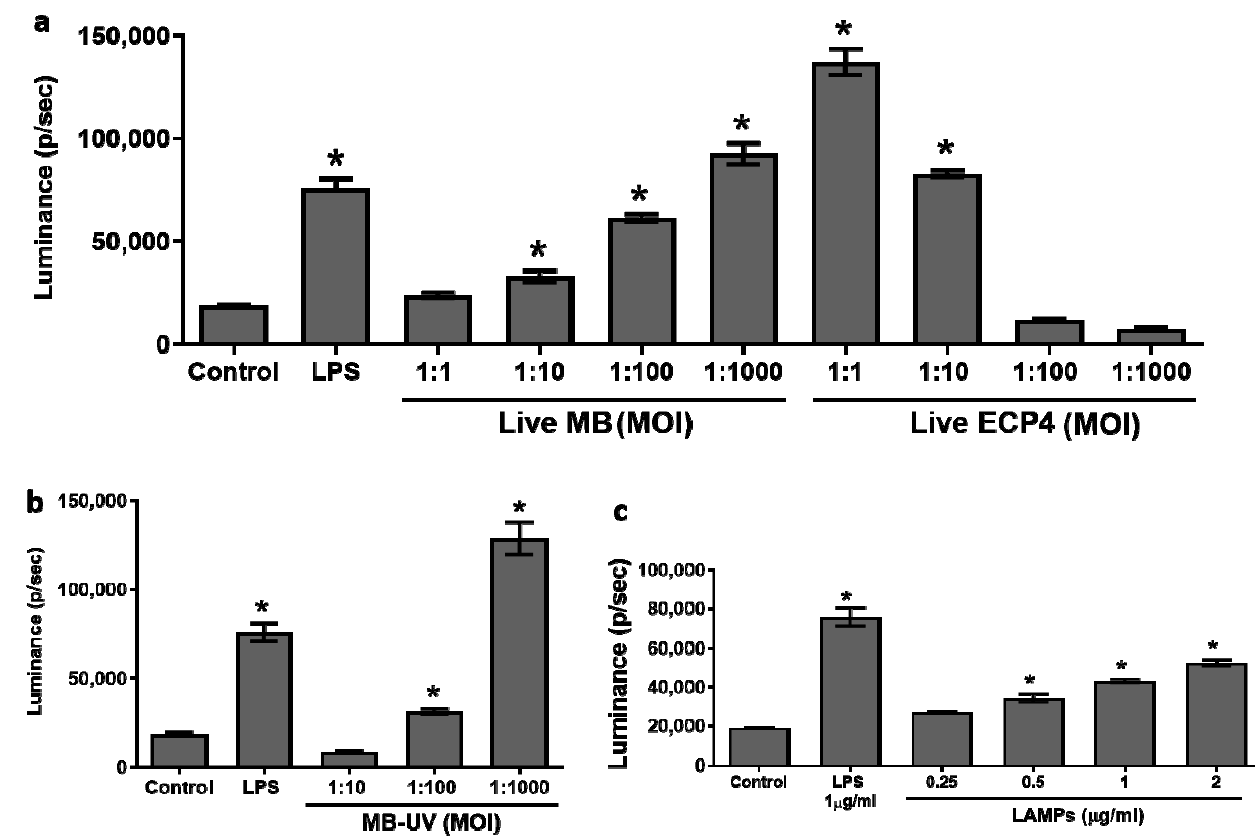
Figure 1. Activation of mMECs. EpH4/NF- κ B transduced cells were treated with different MOIs of live M. bovis (MB) and E. coli (ECP4) ( a ), UV-treated M. bovis (MB-UV) ( b ) and increasing concen- trations of M. bovis -LAMPs ( c ). NF-kB activation was measured via luciferase activity expressed as photons/second. Data are mean ± SE for one experiment performed in triplicate that represent the results of the three similar experiments. * in ( a – c ) indicates statistical significance in comparison with a control group ( p < 0.05).